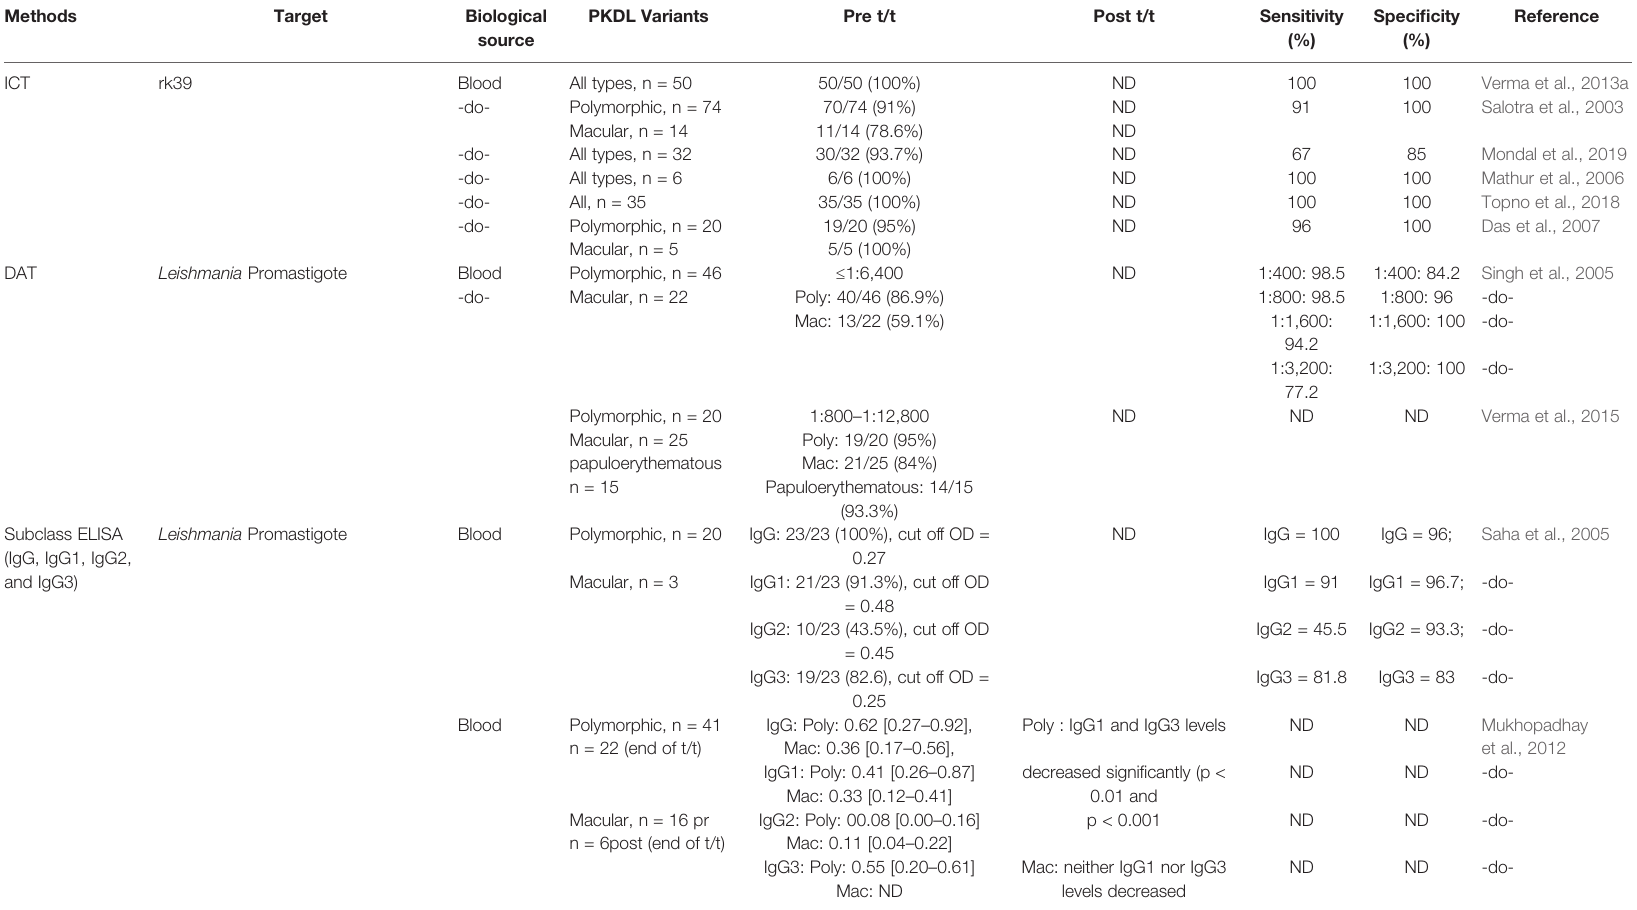
TABLE 4 | Antigen/Antibody Markers of